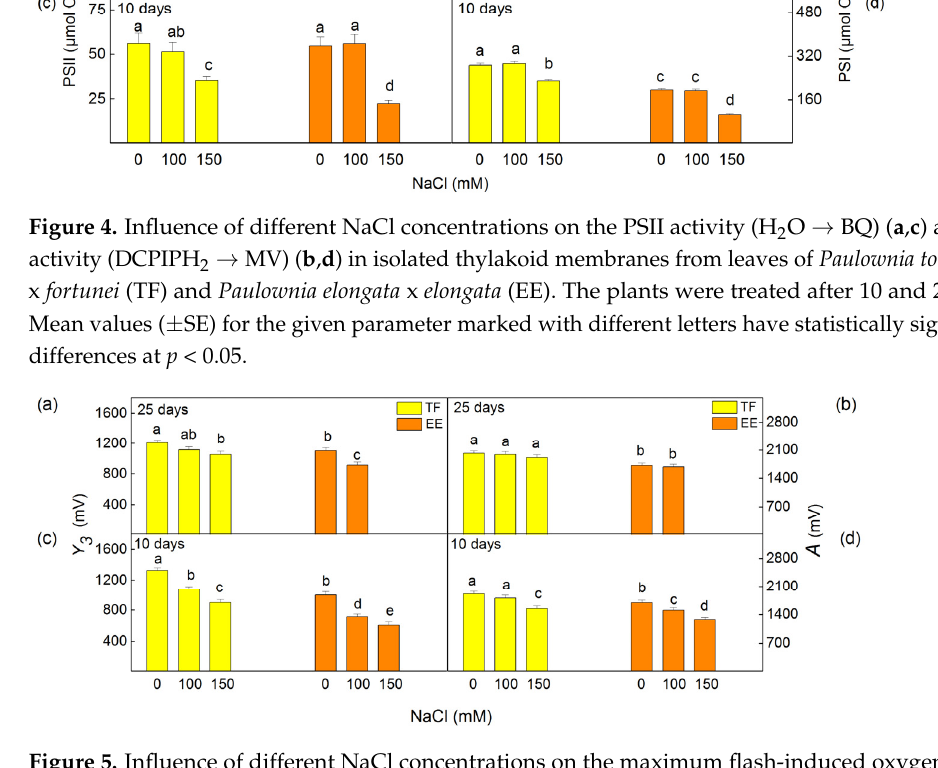
Figure 5. Influence of different NaCl concentrations on the maximum flash-induced oxygen yields ( Y 3 ) ( a , c ) and the amplitudes of initial oxygen burst under continuous illumination ( A ) ( b , d ) of isolated thylakoid membranes from leaves of Paulownia tomentosa x fortunei (TF) and Paulownia elongata x elongata (EE). The plants were treated for 10 and 25 days. Mean values (±SE) for each parameter marked with different letters have statistically significant differences at p < 0.05.